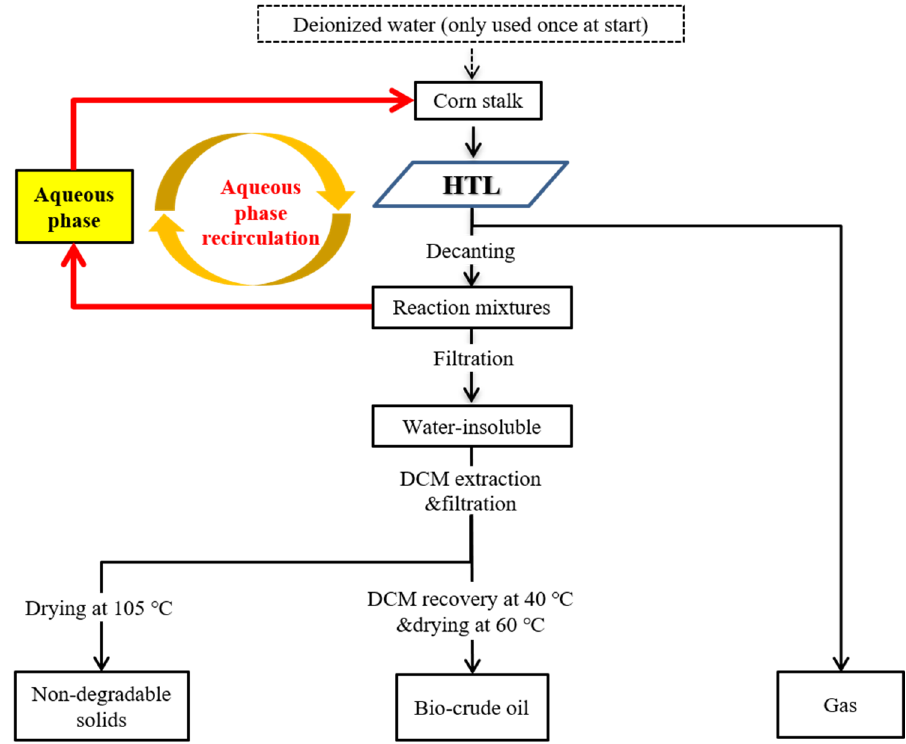
Figure 1. Hydrothermal liquefaction (HTL) products separation and collection procedure.